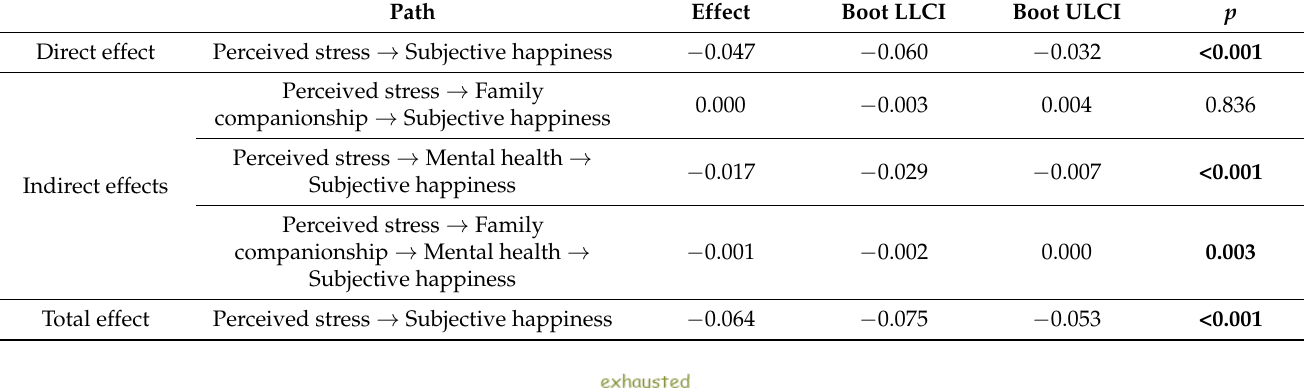
Table 5. Analysis of the chain ‐ mediating effect of family companionship and mental health between perceived stress and subjective happiness.